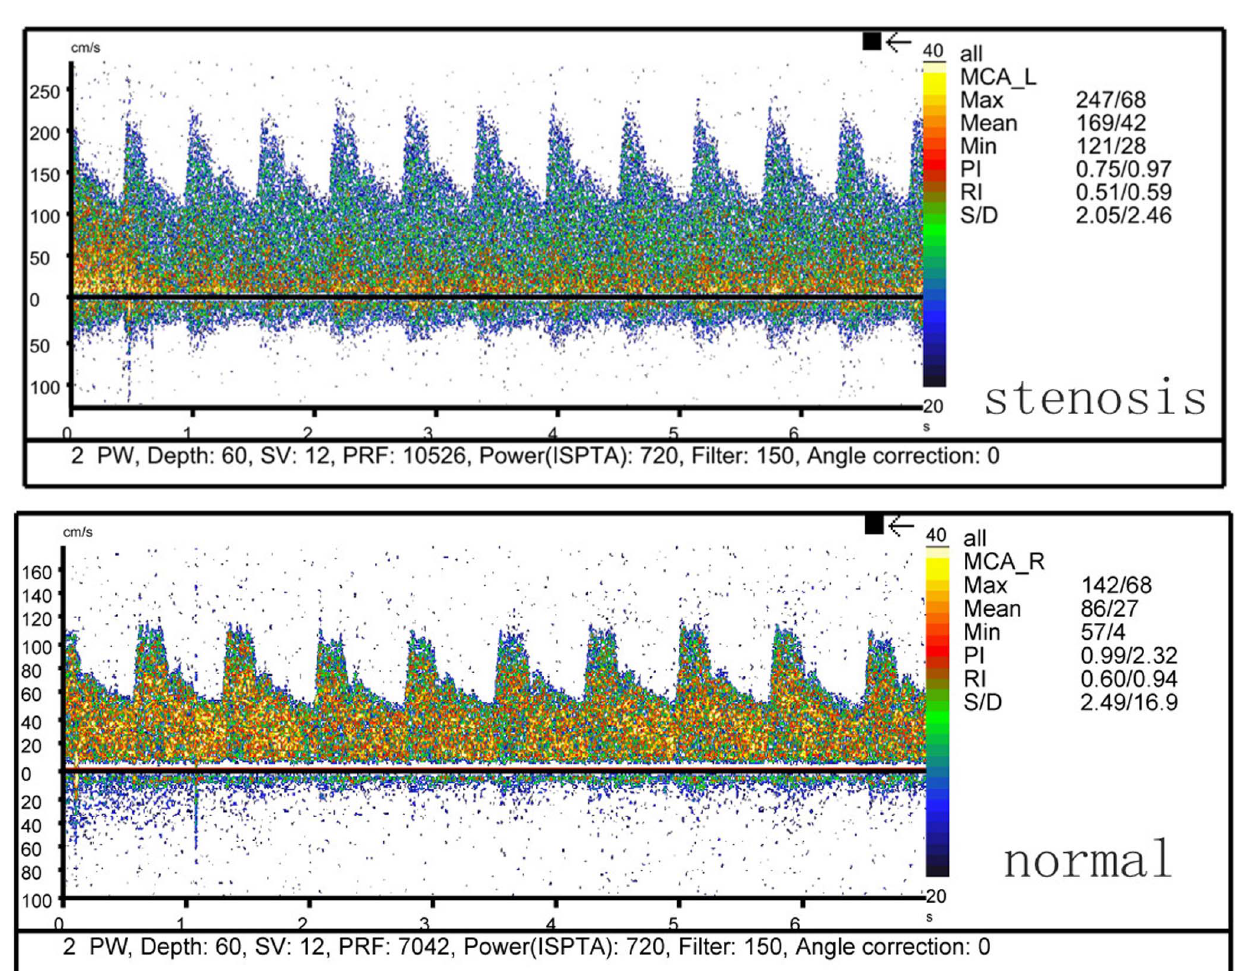
Figure 1. Normal and typical TCD waveform indicative of ICAS in the middle cerebral artery.